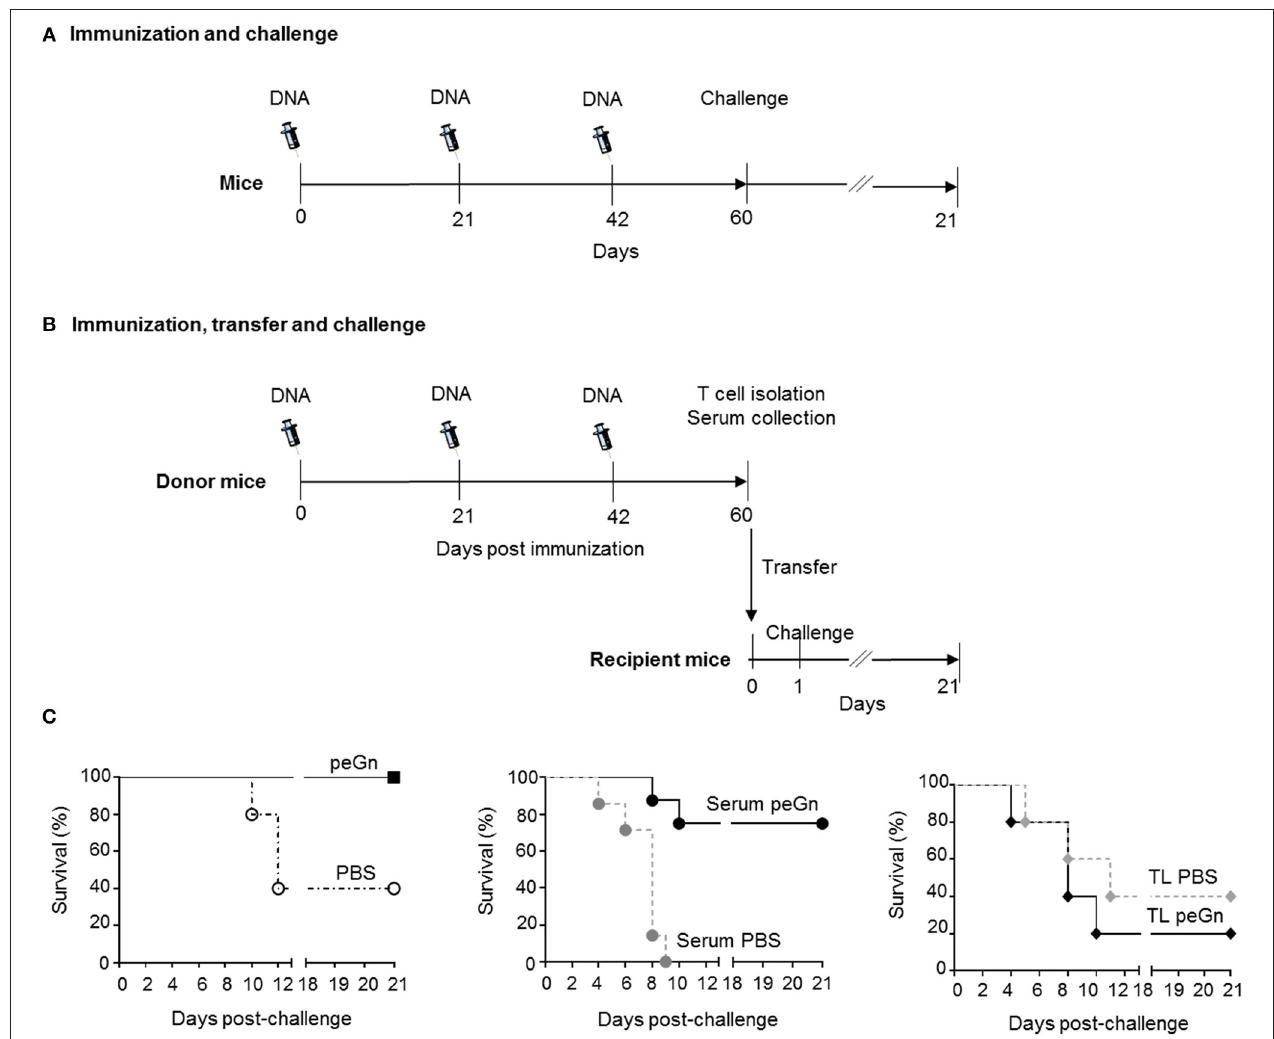
FIGURE 1 | Effects of passive and adoptive transfers of immune effectors from peGn-vaccinated mice on the protection against RVFV. Six to eight-week-old female Balb/c were administered 3 times a day 0, 21, and 42 with 100 µ g of peGn + 20 µ g of pGM-CSF (immunized groups) or PBS + 20 µ g of pGM-CSF (control groups) by intradermal injection in the flank and immediately followed by surface electroporation (1,730 V/cm). In (A) 3weeks after the last immunization (day 60), immunized and control mice ( n = 5 per group) were challenged with 10 4 pfu of RVFV (ZH501 strain). In (B) mice were euthanized to collect serum and splenocytes. Naïve recipient mice received 300 µ l of serum or 10 7 T cells from donor immunized or control mice. Twenty-four hours after the passive (serum) and adoptive (T cells) transfers, mice were challenged with 10 4 pfu of RVFV ZH501, n = 5 for adoptive transfer and n = 7 for passive transfer. In (C) , the survival was monitored daily for 21 days in the vaccinated (peGn + pGM-CSF) and control (PBS + pGM-CSF) groups (left panel), in the passive transfer groups (middle panel) and in the adoptive transfer groups (right panel, TL stands for T lymphocytes) and the percentage of survival is shown in Table 1 . The syringe drawing is from Servier Medical Art which provides open source